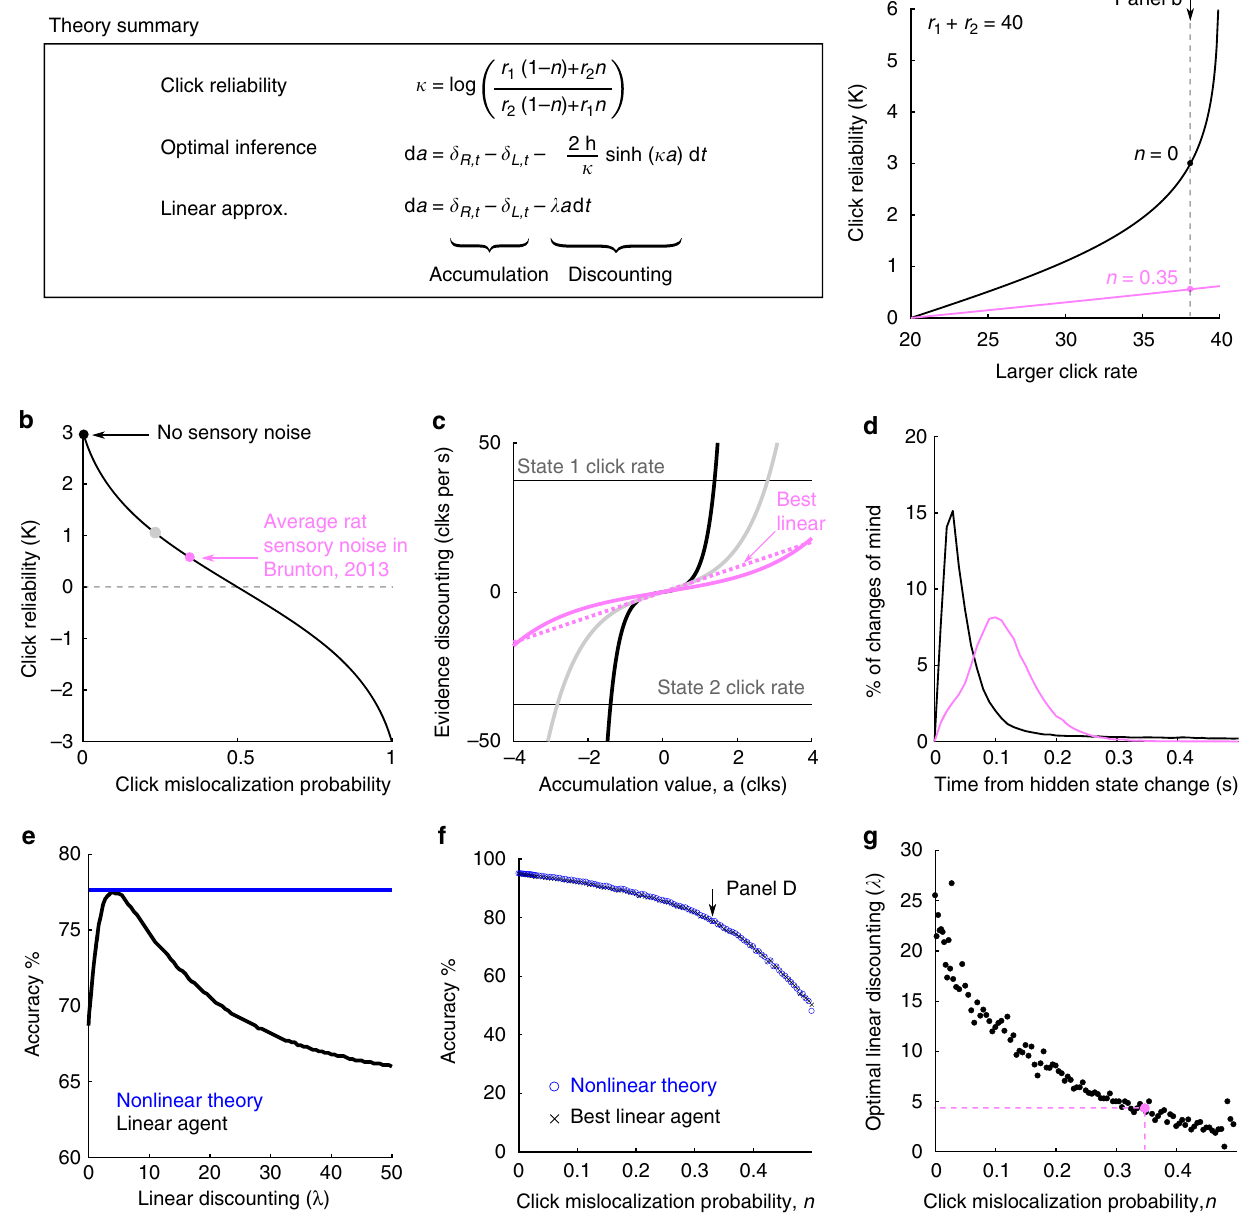
Fig. 2 Optimal discounting rates depends on click reliability and can be well-approximated by linear discounting. a , b The reliability κ of each click depends on the Poisson click rates r 1 and r 2 , as well as the click mislocalization probability n . a κ as a function of click rates with no sensory noise (black), and with the average level of sensory noise reported in Brunton, 2013 12 (pink). Vertical dashed line shows the click rates used in the study. b The reliability of each click depends on how consistently each click can be correctly localized to the side that generated it. At 50% mislocalization each click contains no information about the current state, so κ = 0. The pink dot uses the average level of sensory noise. The grey dot uses an intermediate level of the sensory noise. All values displayed here use the click rates used in the study (38 Hz/2 Hz). c Discounting functions for the three sensory noise levels in ( b ) (same colors). Increasing sensory noise causes the discounting functions to weaken. Horizontal lines show average clks/sec in each of the two states. d Histogram of changes of mind produced by the optimal inference equation. Timing is relative to the last change in the hidden state. (Black) Inference without sensory noise, (pink) inference with average rat level of sensory noise. e The optimal nonlinear discounting function can be approximated by a linear discounting function. If the linear discounting function is tuned appropriately, accuracy is close to the full nonlinear function. f Comparison between optimal nonlinear discounting function (blue) and the best linear approximation (black), in terms of average accuracy for different noise levels. The best linear approximation is effectively equivalent. Arrow indicates parameter values used in ( d ). g The best linear discounting rate λ as a function of sensory noise. Increasing sensory noise decreases the discounting rate. The best linear function is found numerically on a set of 30k trials, which produces some variability for different noise levels. Pink dot indicates average rat sensory